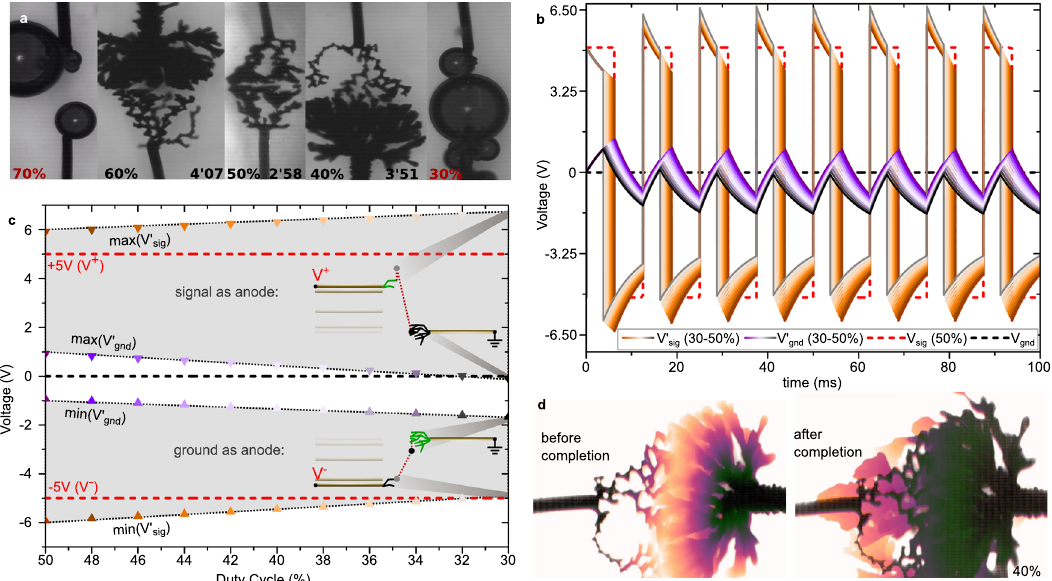
Fig. 5 Dendritic engul fi ng and asymmetry with the duty-cycle (dc). a Microscope pictures of ePEDOT dendritic formations (signal wire: top, ground wire: bottom) at completion time after growth under different duty cycles ( V p = 5 V, V off = 0 V, f = 80 Hz — the two extreme cases dc = 30 and 70% where taken at t = 1 min). b Simulation of the V ’ sig ( t ) and V ’ gnd ( t ) dynamics under a pulse waveform ( V p = 5 V, V off = 0 V, f = 80 Hz) with various duty cycles between 50 and 30% (assuming the equivalent circuit of Fig. 4f inset with rigid parameters as R CT = 2 M Ω , 1/ G = 80 k Ω and C dl = 10 µ F). c Dependency of V ’ sig and V ’ gnd voltages at the change of the signal polarity (spike) upon variations of the waveform ’ s duty cycle between 50 and 30% from simulations displayed in Fig. 6c (the two diagrams show the different voltage drops between the dendrite at both changes of the waveform ’ s polarity for dc = 30%). d Color-encoded images of a dendritic growth at dc = 40% showing two speci fi c dynamics before and after completion. Scatters and curves ’ color encodings with a duty cycle in b and c are